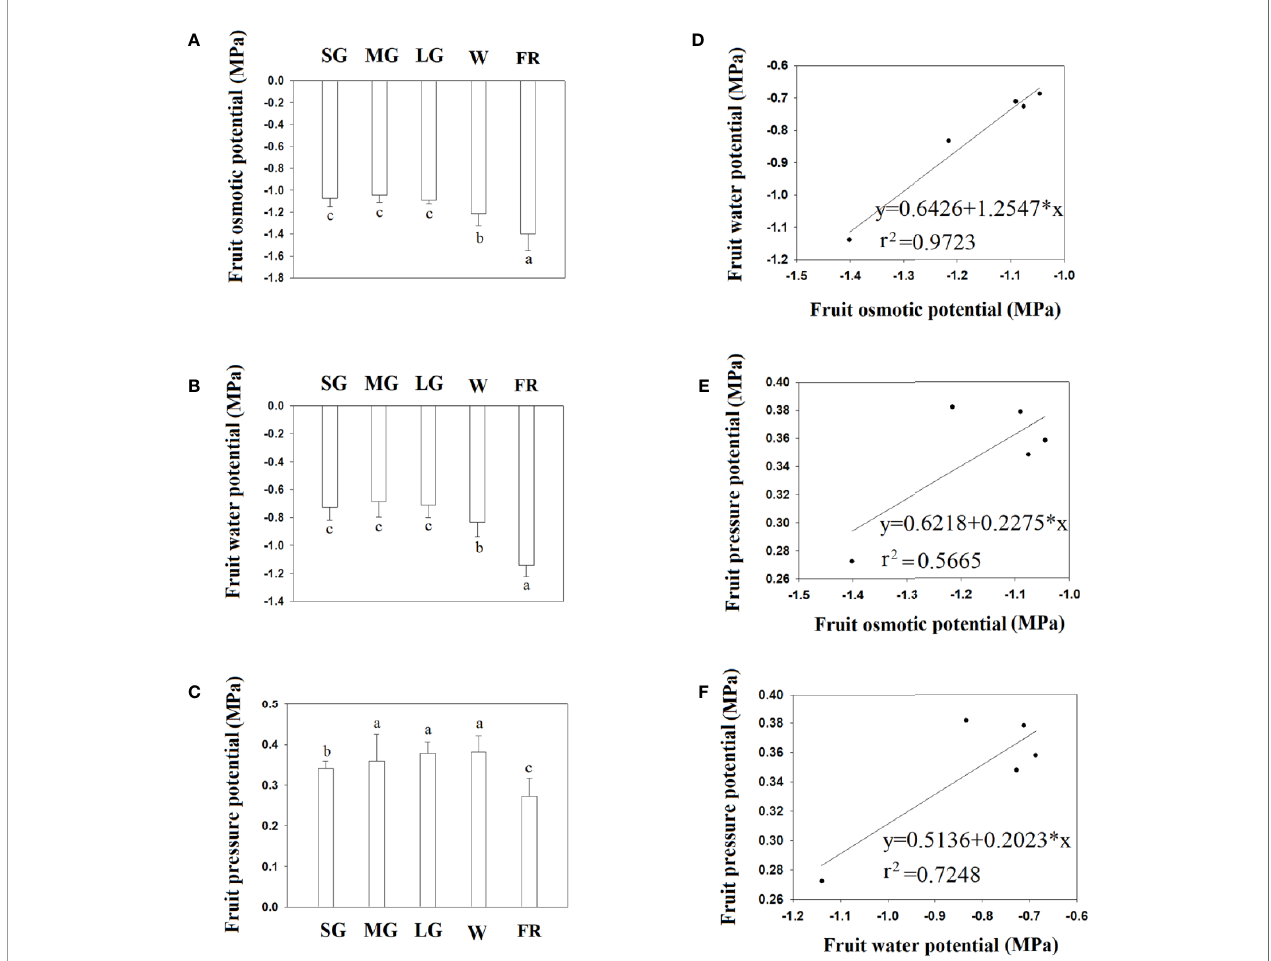
FIGURE 2 | Changes in fruit water status during fruit development and ripening. (A) Changes in fruit water potential. (B) Changes in fruit osmotic potential. (C) Changes in fruit pressure potential. (D – F) Correlation analysis of the different water relationship parameters. (D) Osmotic potential vs. water potential. (E) Osmotic potential vs. pressure potential. (F) . Pressure potential vs. osmotic potential. SG, small green; MG, middle green; LG, large green; W, white; and FR, full reddening. In (A – C) , bars denote the mean ± SD of four biological replicates. Different letters denote signi fi cant differences as determined by a Student ’ s t-test, P ≤